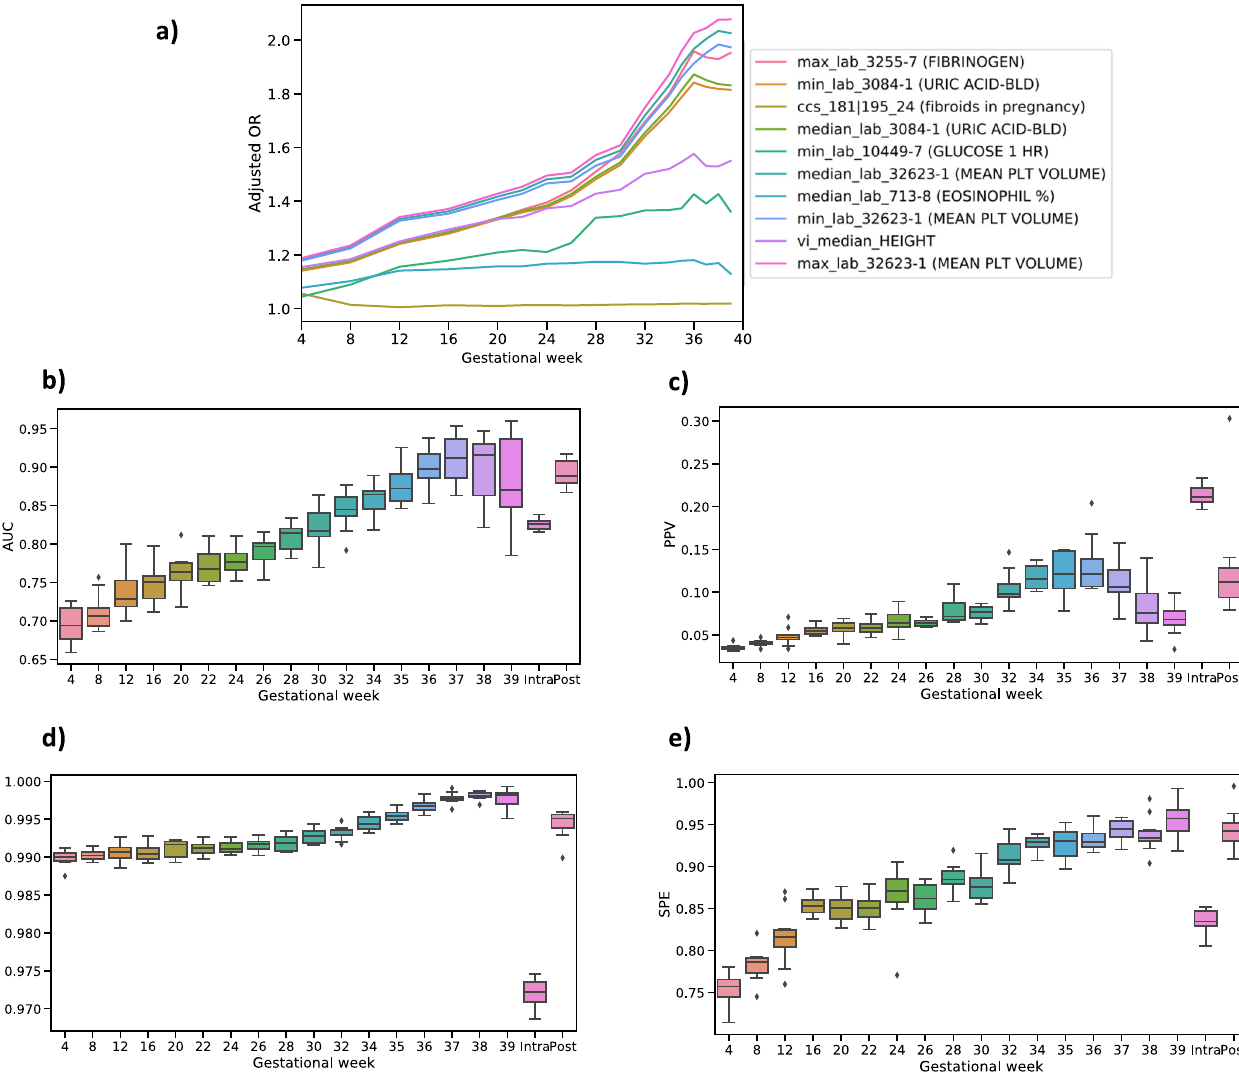
Fig. 2 Model performance at different time points. a Features indicate different dynamical signals across the gestational weeks based on different adjusted odds ratio (OR). b Area under receiver operating characteristic curve (AUC) score for each time point. c Positive predictive value (PPV), along with preeclampsia risk in the population, at each time point. d Negative predictive value (NPV) at each time point. e Speci fi city (SPE) at each time point. The variation estimates were derived from 10-folds cross-subject validation from training set. For the box plots shown in b – d , the median, interquartile (1st and 3rd) range, and minimum and maximum values, are depicted by the center line, the bounds of the boxes, and the whiskers